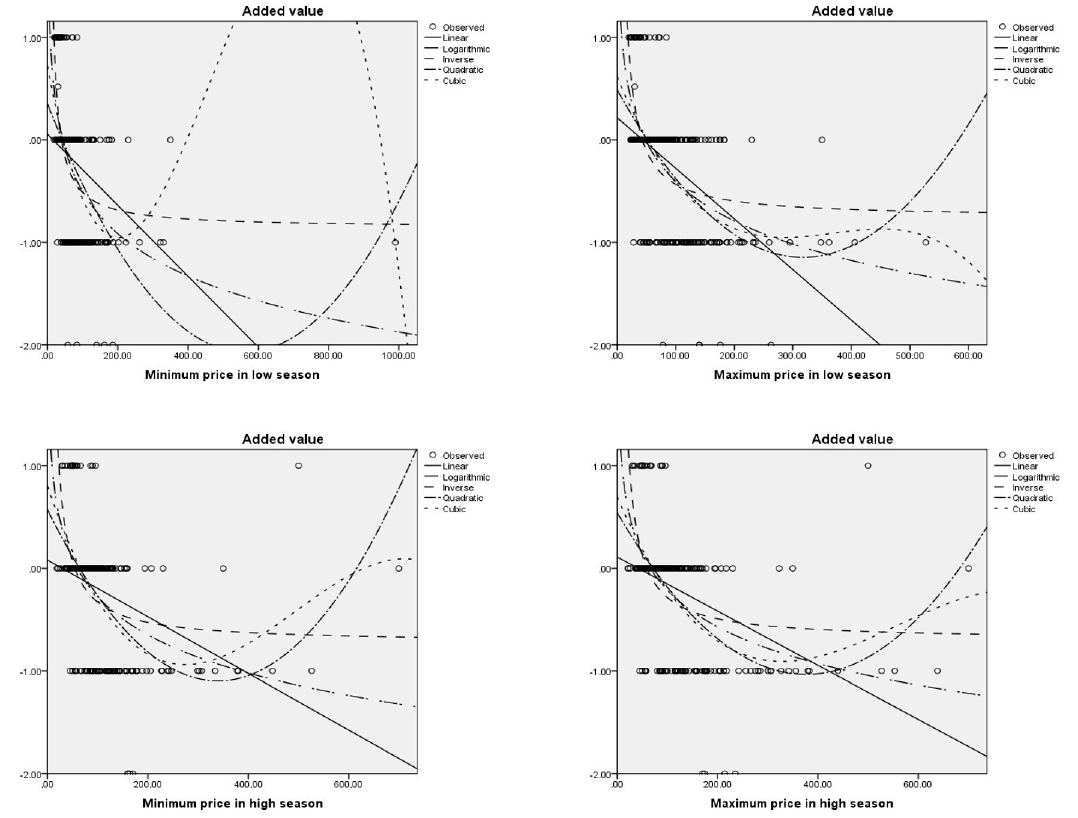
Figure 1. Functions of the regression analysis with the best fit in all destinations.